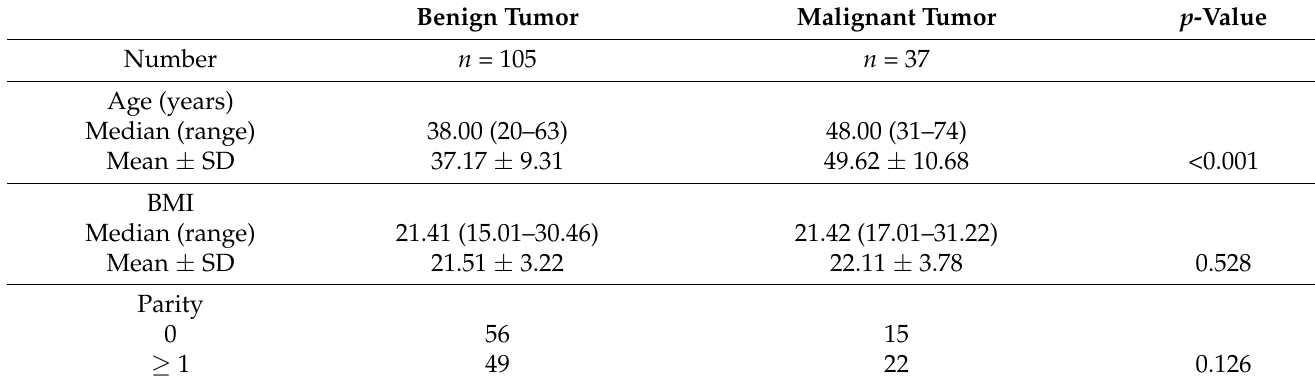
Table 1. Demographic and clinical characteristics of the investigative